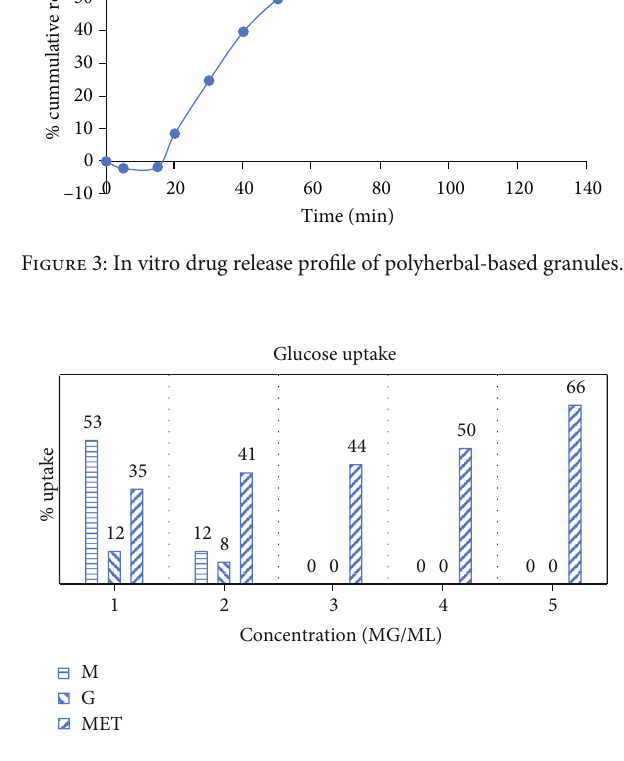
Figure 4: Glucose uptake by yeast cell in 5 mM concentration of glucose in the presence of mixture, granules, and metformin. The data points are representing as mean ± SEM , n = 3 .